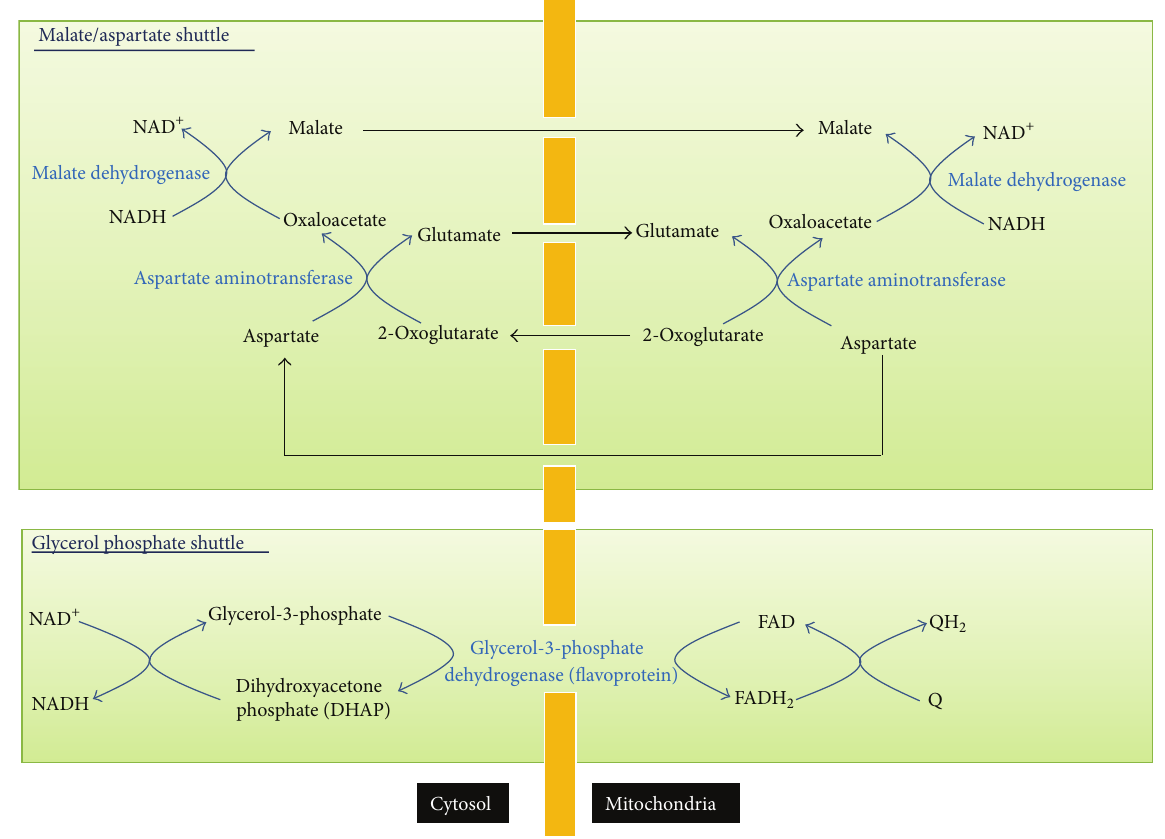
Figure 6: The two redox shuttles transporting cytosolic NADH into mitochondria. These are malate/aspartate shuttle and the glycerol phosphate shuttle. The former is reversible and only transports NADH when cytosolic NADH levels are high; the latter is irreversible and can transport NADH from cytosol to mitochondria even when cytosolic NADH levels are low.